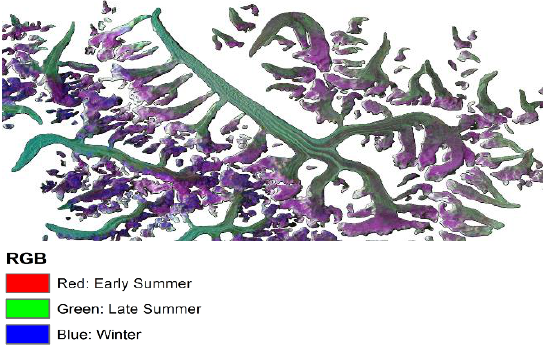
Figure 19: Multi-temporal SAR image composite of Bara Shigri glacier